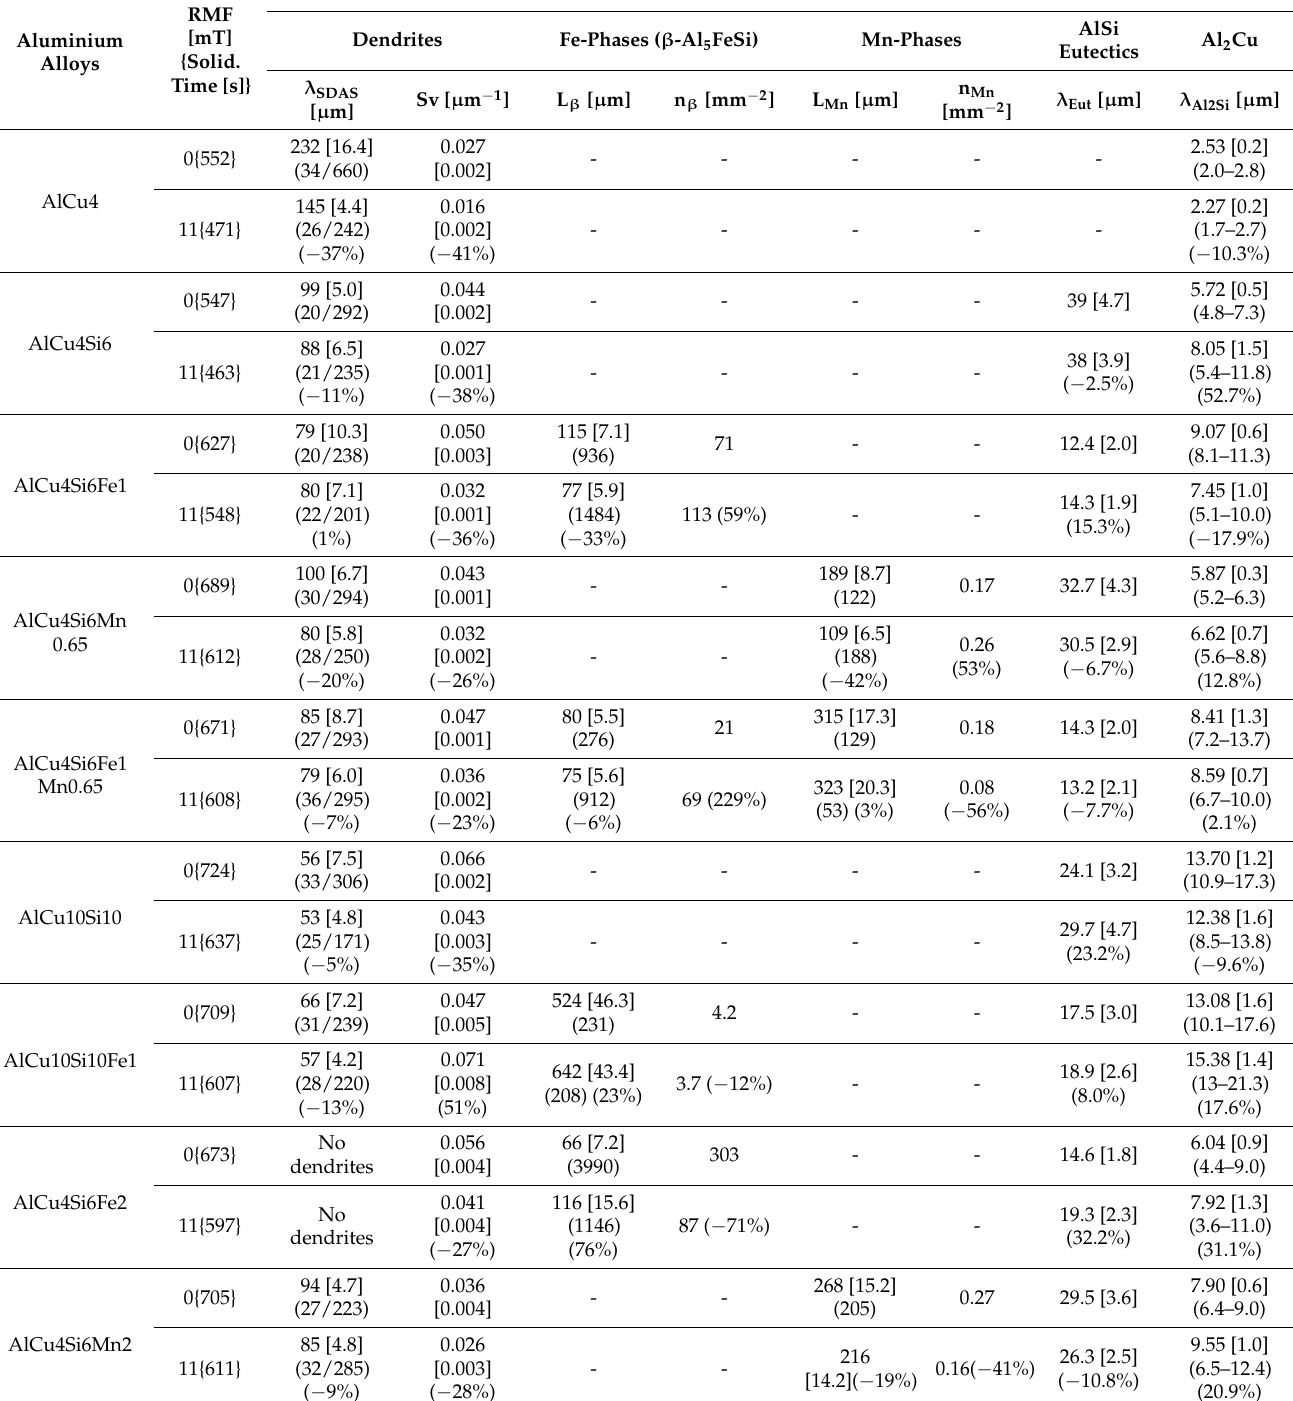
Table 1. Microstructure parameters measured on investigated micrographs of AlCu